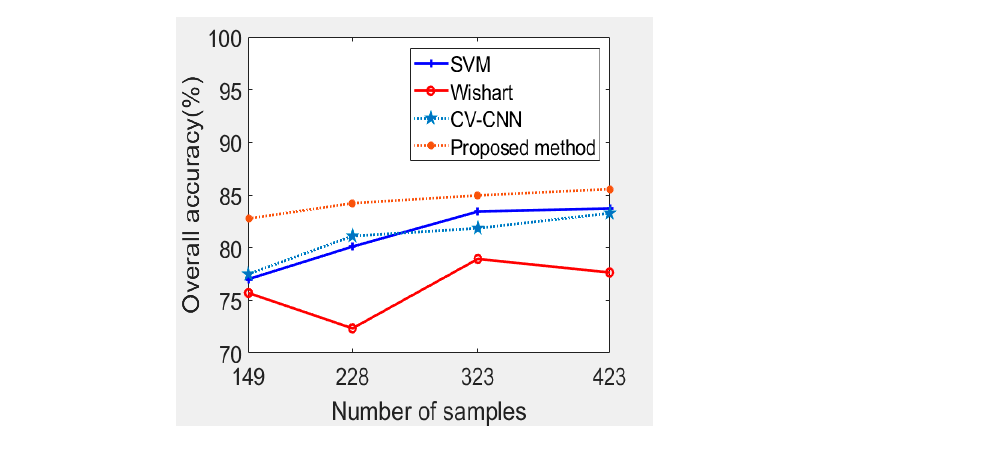
Figure 10. Trends of the OA with different numbers of training samples for the Oberpfaffenhofen dataset.